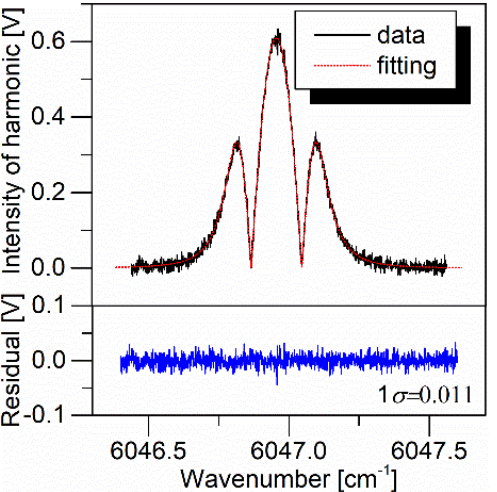
Figure 16. Measured data and its fitting of the harmonic for 400 ppm CH 4 .